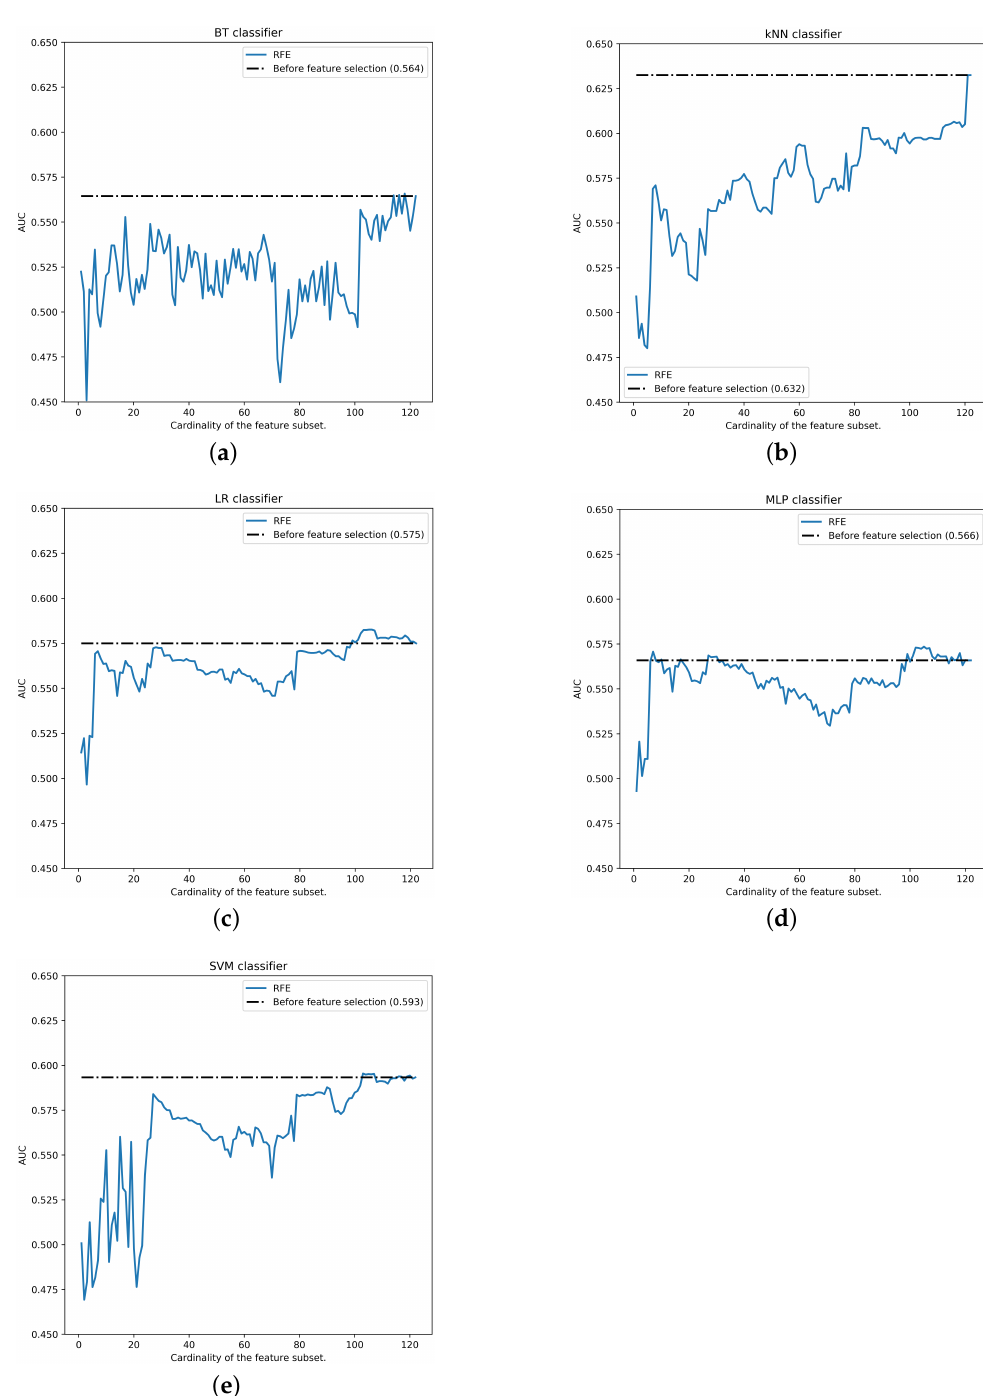
Figure 8. Performance for postmenopausal data partition (by classifier): ( a ) BT, ( b ) k-NN, ( c ) LR, ( d ) MLP, ( e )